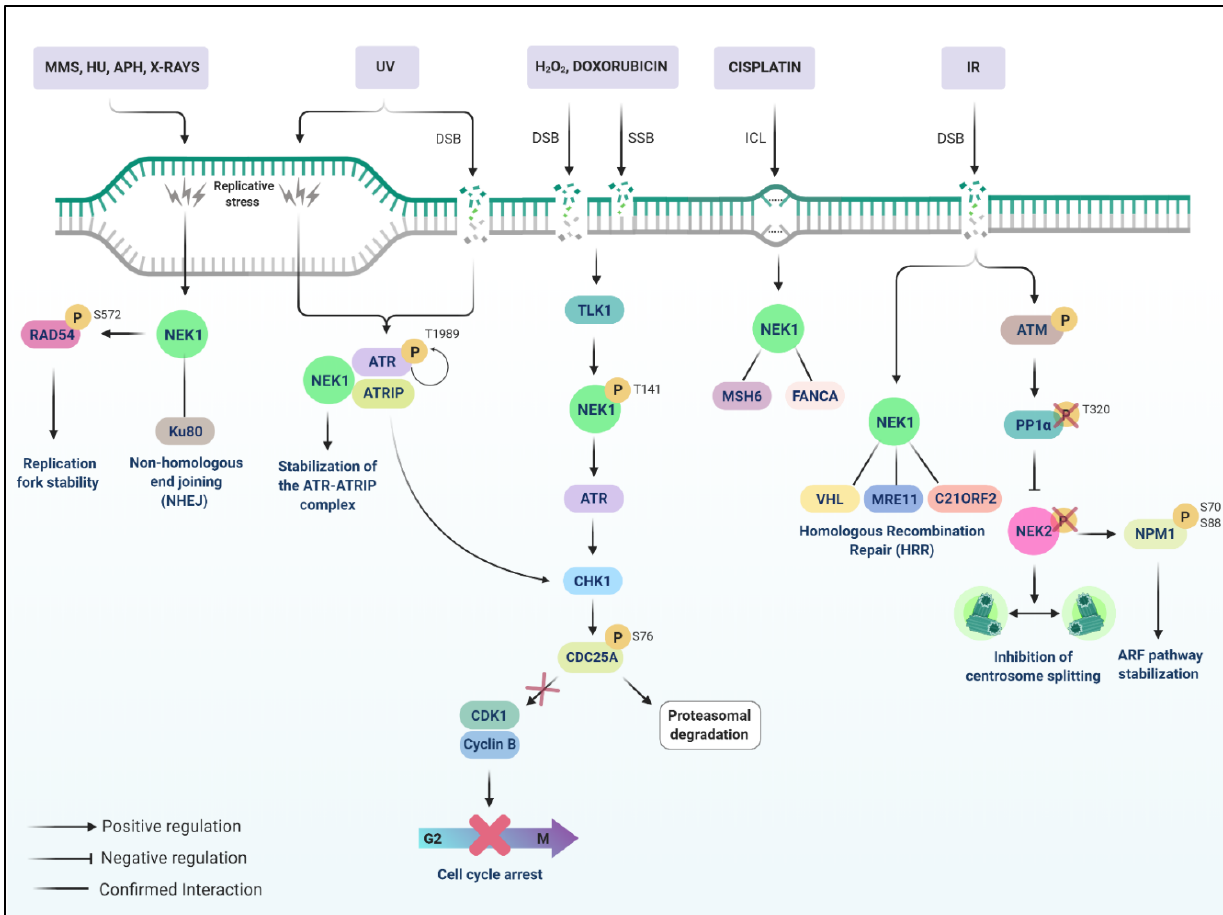
Figure 1. NEK1 and NEK2 play key roles in the DDR pathway. NEK1 is required for replication fork stability by phosphorylating Rad54 at S572. Moreover, the TLK1 > NEK1 > ATR > CHK1 axis plays a major role in DDR, involving cell cycle arrest through CDC25A phosphorylation and CDK1 inhibition. TLK1 phosphorylates NEK1 at T141 and NEK1 interacts with ATR, promoting the stabilization of ATR-ATRIP complex and autophosphorylation of ATR at T1989. NEK2 regulates centrosome disjunction since ATM activates the PP1 phosphatase, which in turn dephosphorylates NEK2, leading to the inhibition of centrosome splitting. The PP1a phosphatase activation also counteracts the NEK2-dependent phosphorylation of NPM/B23, which stabilizes the ARF pathway. NEK2 also upregulates the Wnt1/β-catenin pathway.